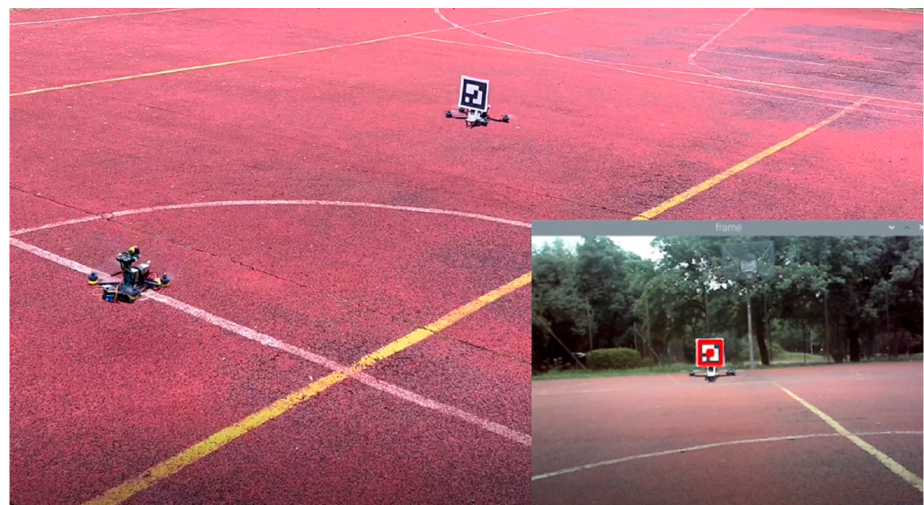
Figure 8. Flight in a straight line behind the leader. The bottom right image was taken by the camera, showing the detected marker.